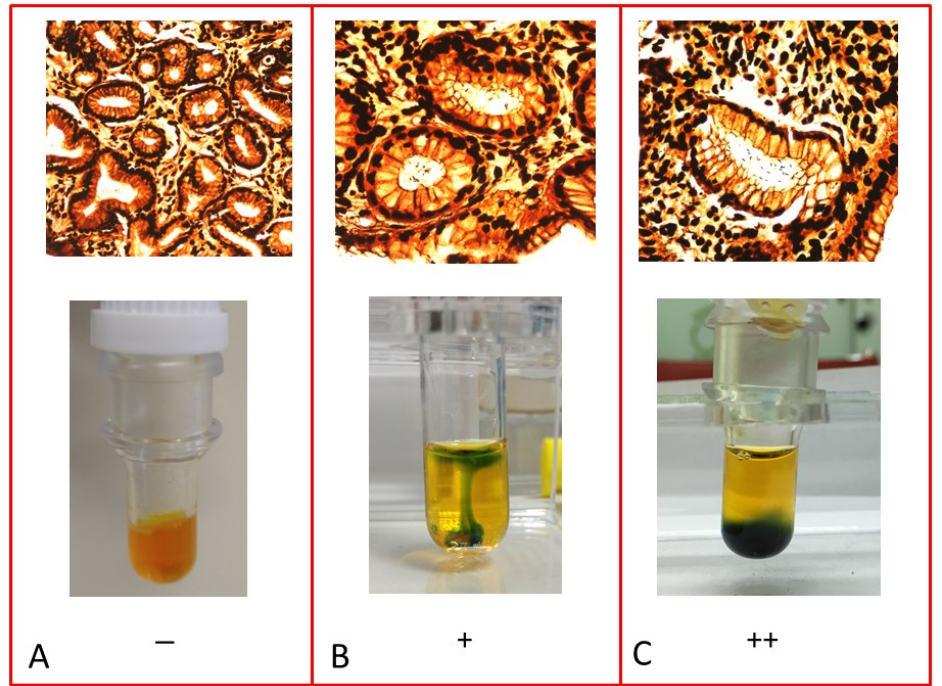
Figure 2. Illustration of the iNatal duo test results compared with histology (Warthin–Starry stain) in representative patients with negative ( − ) ( A ), weakly positive (+) ( B ) and positive (++) results ( C ). Thanks to the bromothymol blue indicator, the results are easily readable, even in the case of low bacterial load ( B